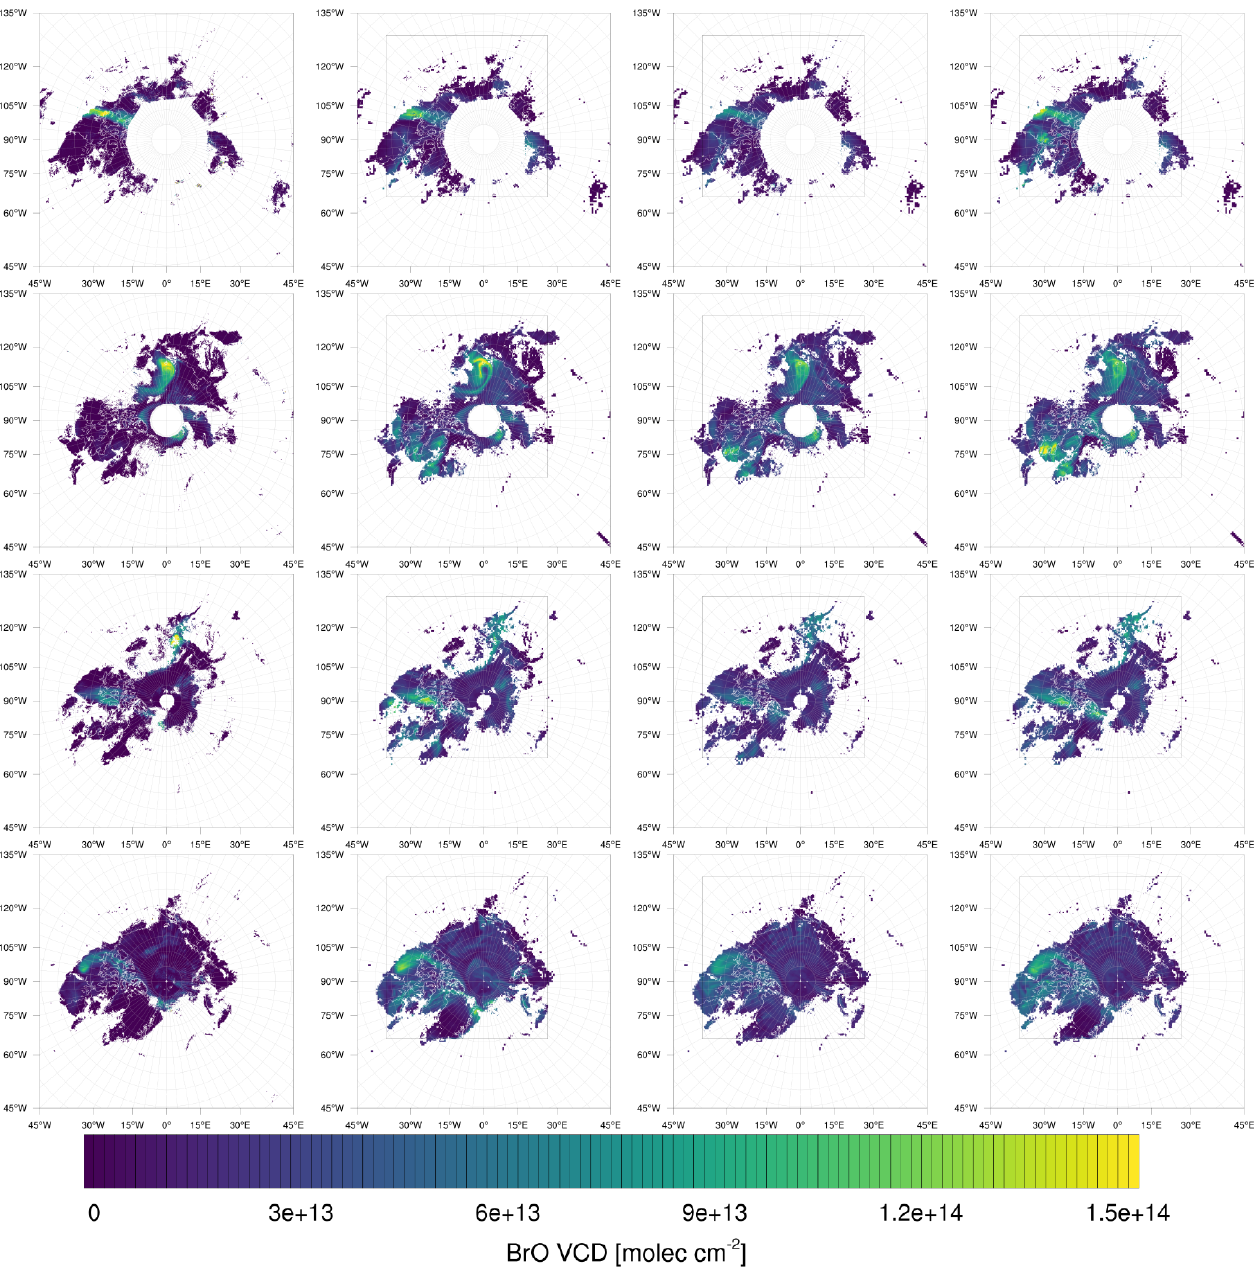
Figure 9. Observed (left) and simulated (infinite, low, and medium bromide from left to right) tropospheric BrO VCDs in 2019. From top to bottom: 27 February; 19, 27 March; 5